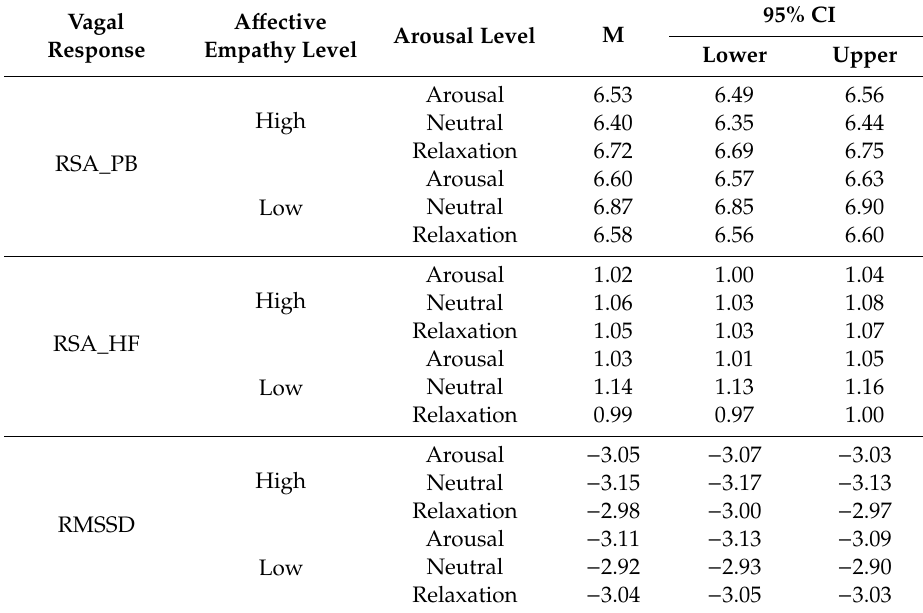
Table 7. Descriptive statistics of vagal response depending on a ff ective empathy level and arousal. M = Mean, SD = Standard deviation. 5% CI = 95% of confidence interval.